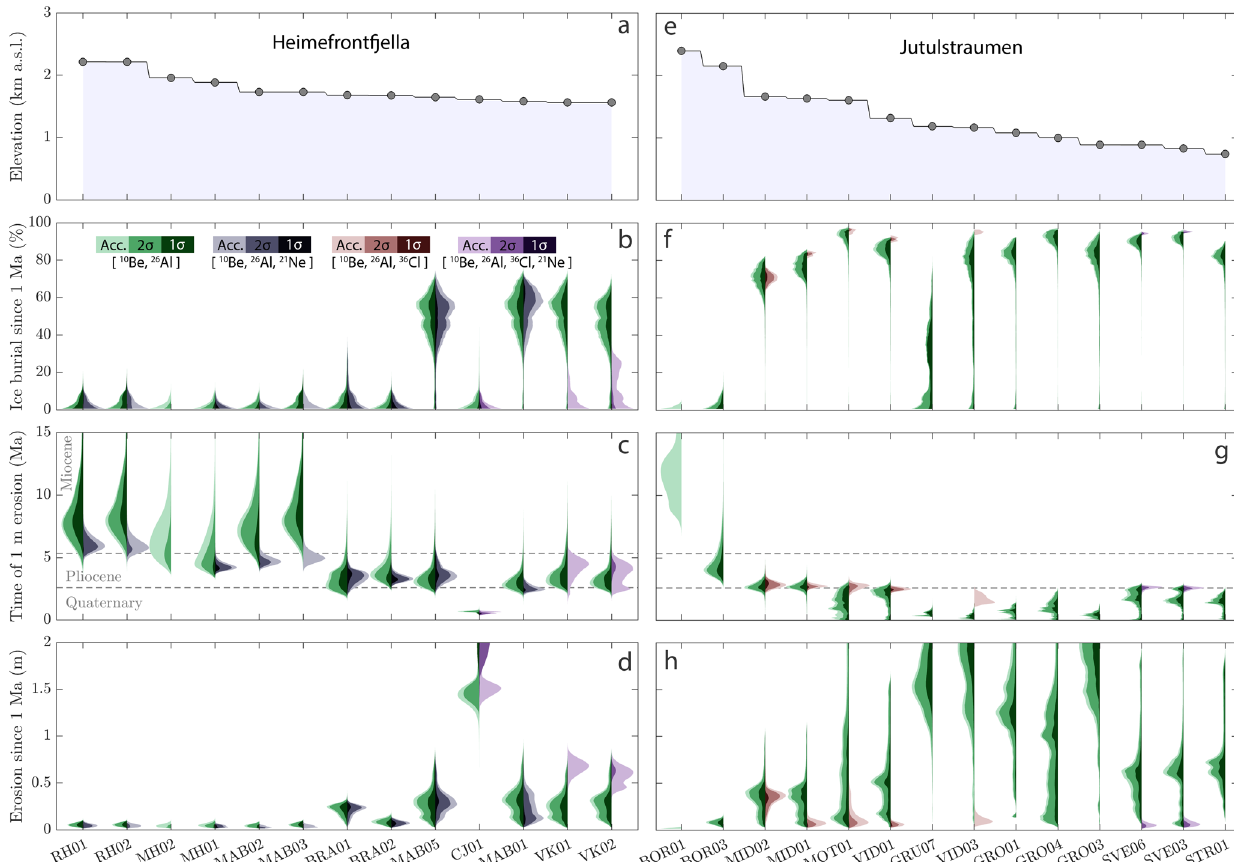
Fig. 4 Outcome of inversion approach. Inversion results for a – d Heimefrontfjella and e – h Jutulstraumen . a , e Samples ordered by elevation above sea level (sample labeling at the bottom). b – d and f – h Distributions of derived parameters for accepted models colored by nuclides included in Monte Carlo inversion according to legend in b, b , f ice burial since 1 Ma (%) derived from the glaciation threshold ( δ 18 O th ), c , g time of entering within 1 m of present- day surface, and d , h erosion since 1 Ma. Acc. accepted models. Note that the accepted models for each inversion sometimes only yield solutions where the modeled nuclide concentrations of the accepted ‘ best- fi t ’ models fall >1 – 2 σ outside of the measured concentrations for one or more nuclides (indicated by color brightness according to legend in b ), e.g., BOR01, VK01 ( 10 Be- 26 Al- 36 Cl- 21